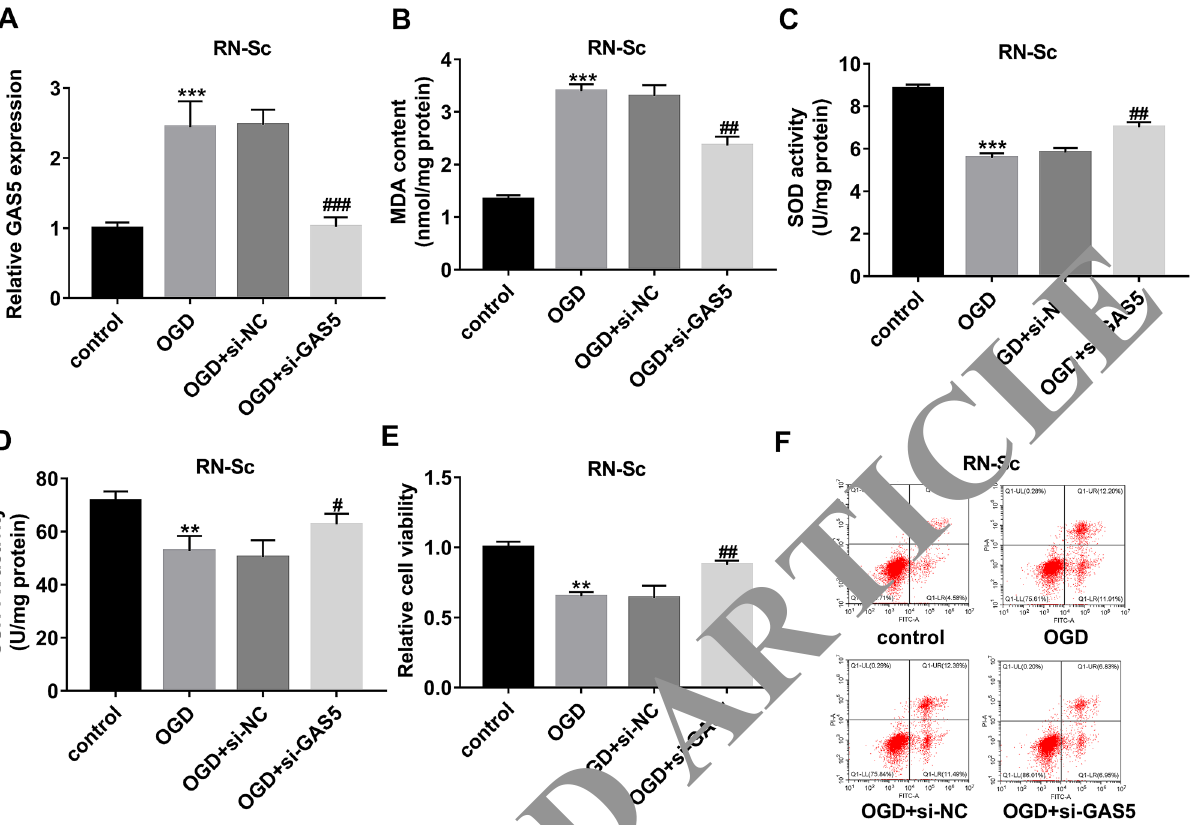
Figure 2. GAS5 knockdown abated OGD-induced oxidative stress and cell injury in RN-Sc neuronal cells. (A-F) RN-Sc cells were transfected with si-NC or si-GAS5. At 24 h post transfection, cells were treated with or without OGD/R. ( A ) After 12 h of reoxygenation, GAS5 level was measured by RT-qPCR assay. ( B – D ) MDA content, SOD activity and GSH-Px activity were examined by corresponding kits at 12 h post reoxygenation. ( E ) Cell viability was measured by CCK-8 assay at 12 h upon reoxygenation. ( F ) Cell apoptotic rate was detected by flow cytometry at 12 h after reoxygenation. ** P < 0.01, *** P < 0.001, # P < 0.05, ## P <